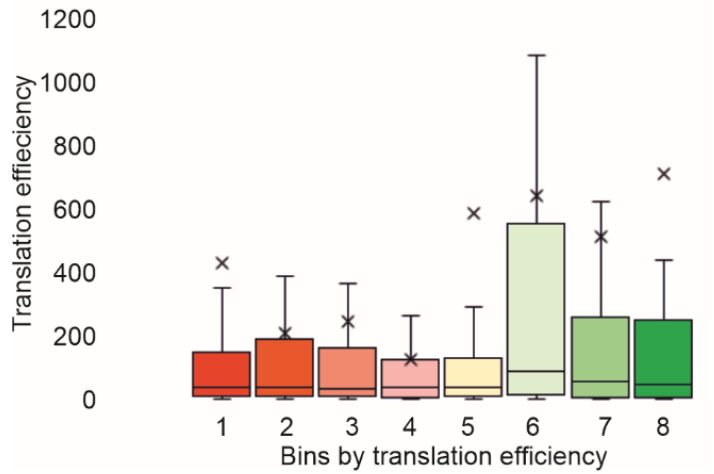
Figure 4. Comparison of translation efficiencies observed with Flow-seq and those obtained with ribosome profiling [19]. Bins sorted with translation efficiency were marked below the bars. Y -axis corresponds to the translation efficiency determined using ribosome profiling. Quartile ranges are shown as solid bars (25% to 50%). See Supplementary Figure S2 for comparison with other ribosome profiling experiments.